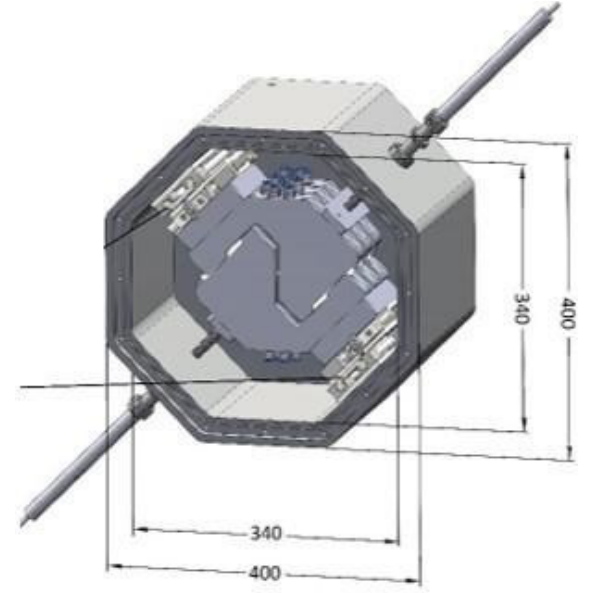
Fig. 13. Conical Collimator design of METU-DBL. Linear drives control leaves which cut the incoming beam. (All dimensions are given in millimeters).